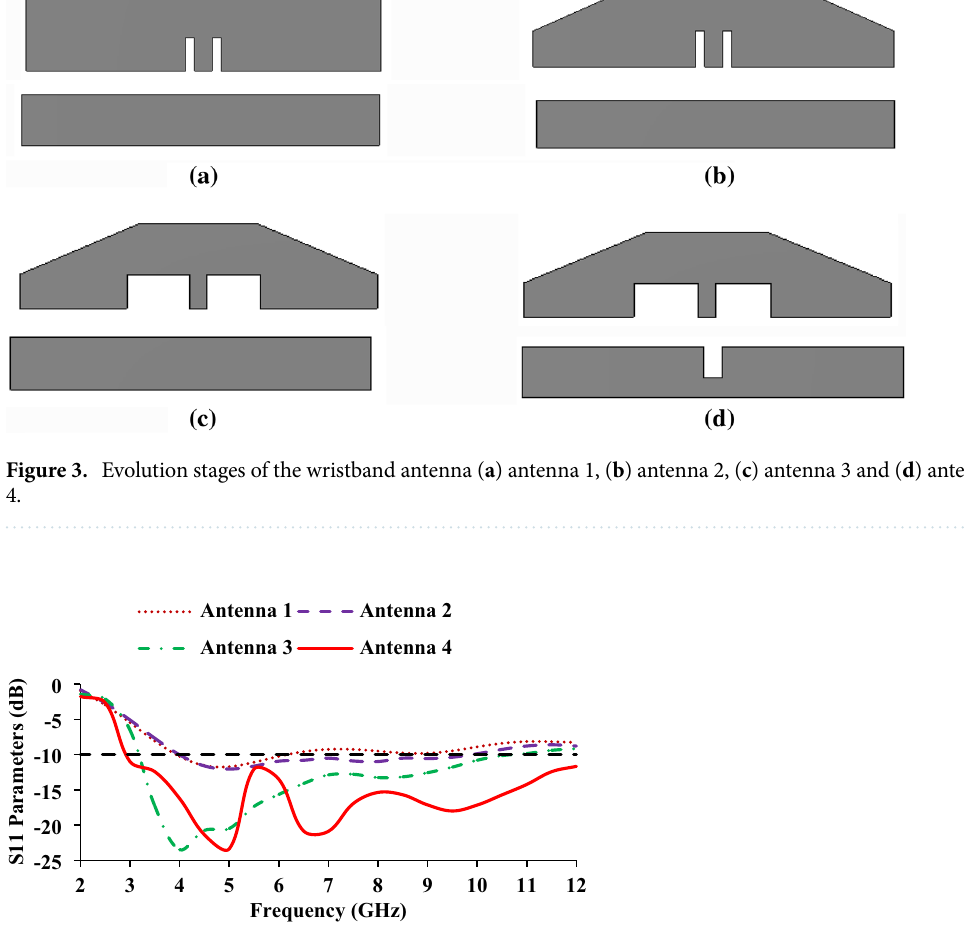
sizes for different age groups, such as for kids and adults. For the proposed work, an adult size wristband with a circumference of 202 mm and dimension of 2.08 λ 0 , where λ 0 corresponds to the lowest operating wavelength, is chosen. The height and thickness of the substrate are 12 mm and 2 mm, respectively. The total area of the antenna element on the wristband is approximately 10 × 40 mm 2 (0.09 λ 0 × 0.36 λ 0 ). Design process. For monopole antennas, the lower band-edge frequency ( f is calculated using Eq. (1) 21